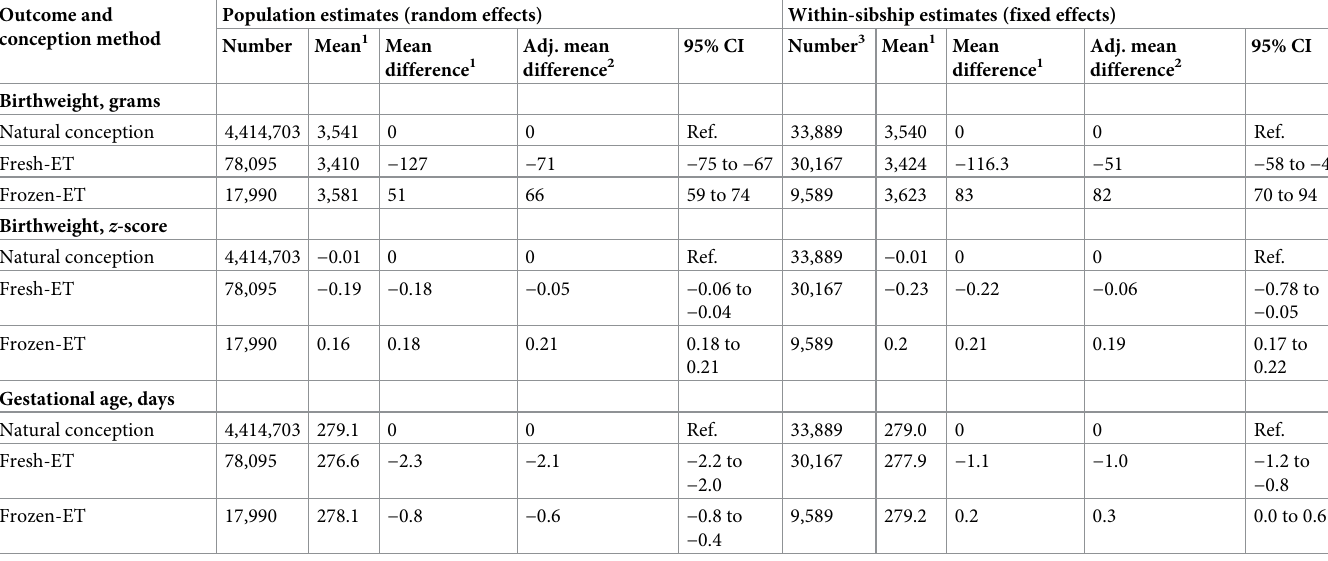
Table 2. Birthweight and gestational age by conception method: Population estimates and within-sibship estimates in main sample 1 (minimizing selection). Outcome and conception